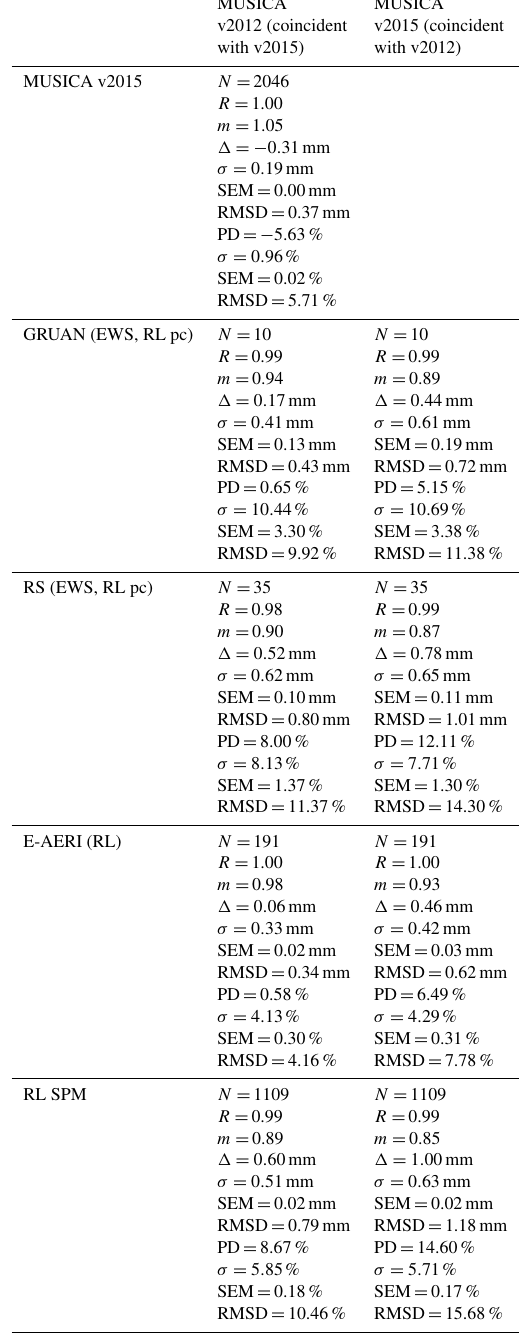
Table 7. Results of comparisons between Ridge Lab instruments and coincident MUSICA v2012 and v2015 datasets, including num- ber of coincidences ( N ), correlation coefficient ( R ), slope of the correlation best fit line ( m ), mean difference ( (cid:49)) , standard devia- tion of difference ( σ) , standard error of the mean (SEM), and root- mean-square difference (RMSD) in mm ( X − Y ) and % (2 × (X − Y)/(X + Y) × 100%). Instruments along the x axis (top) are X while instruments along the y axis (side) are Y in Eqs. (1) and (2). High- resolution version is available in Table